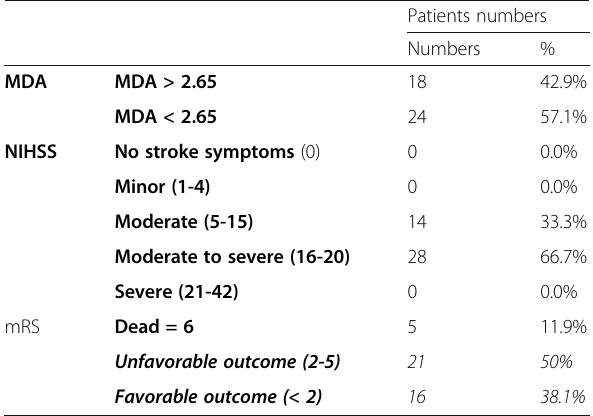
Table 1 Serum malondialdehyde, clinical severity and functional outcome of the studied ischemic stroke patients